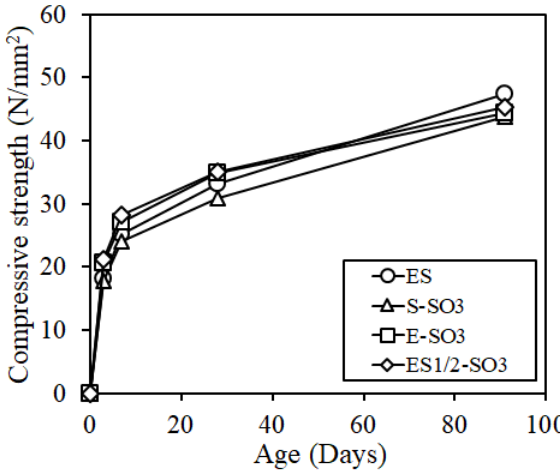
Figure 10. Compressive strength.